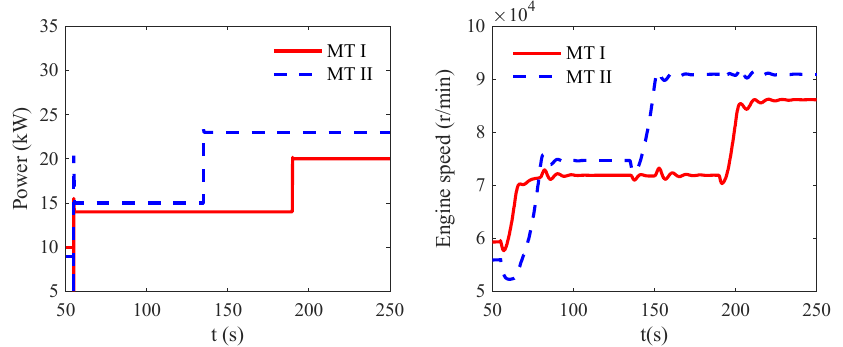
Figure 11. MT state variations during the mode switching process.